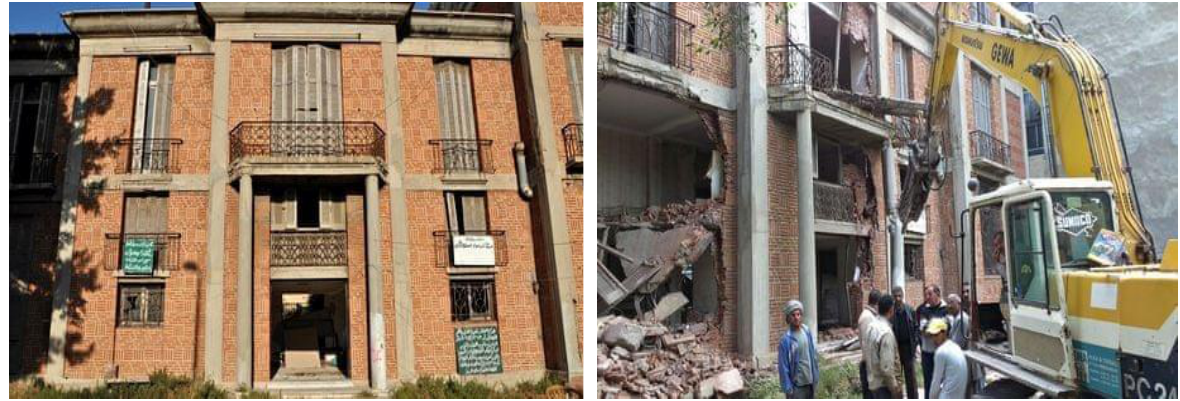
Figure 9: Villa Gustave Aghion, Ahmed Ismail Street - Alexandria (News,